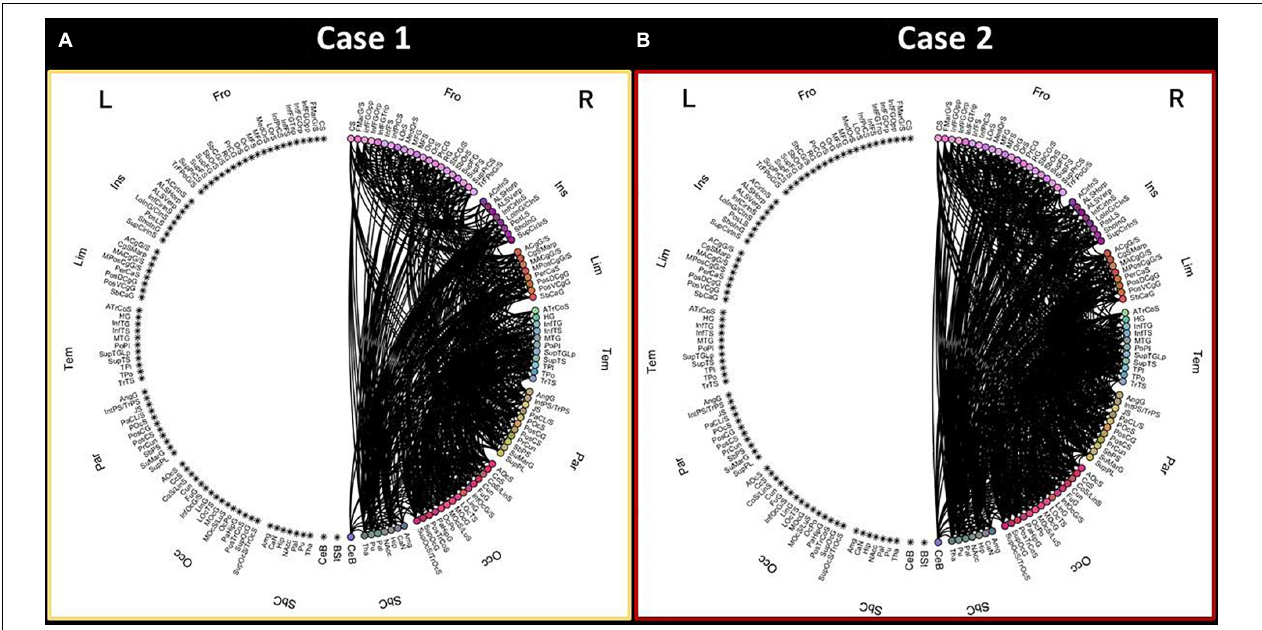
FIGURE 2 | Connectograms showing the connectivity pattern of the right hemisphere for the two stroke patients. The connectogram of Case 1 (A) is reported on the left, while the connectogram of Case 2 (B) is represented on the right. L-left hemisphere, R-right hemisphere, Fro-frontal, Ins-insular, Tem-temporal, Par-parietal, Occ-occipital, Sbc-subcortical, CeB-cerebellum, Bst-brainstem. Brain parcels are reported with standard labels provided for the Destrieux